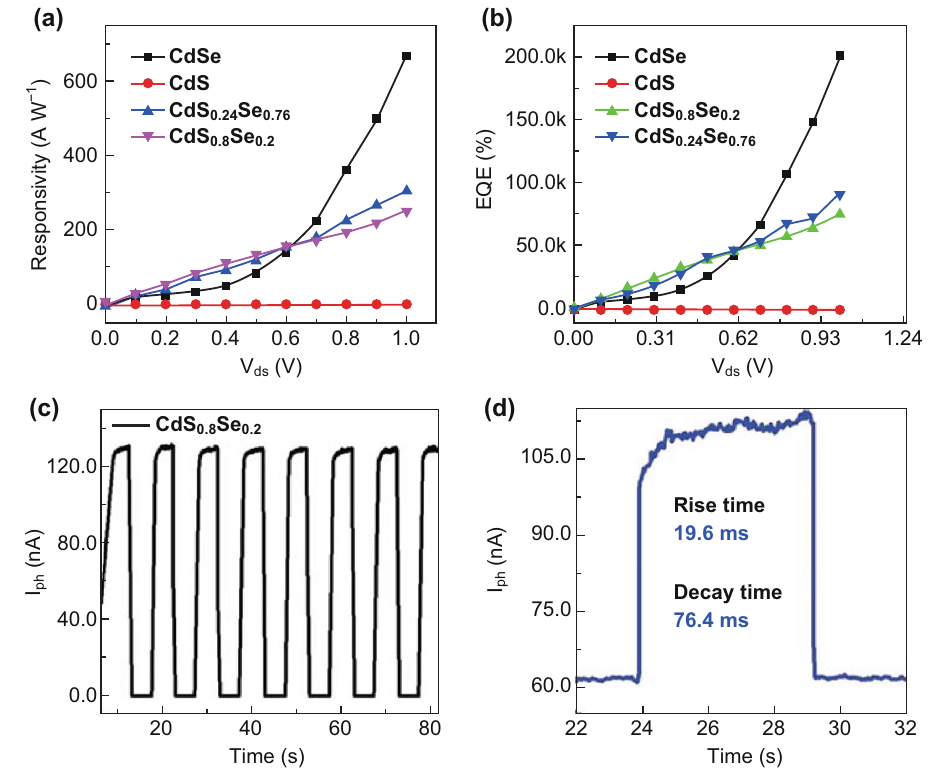
Fig. 5 Photodetection properties of the directional CdS x Se 1 - x NWs. a The responsivity of the CdS x Se 1 - x nanowire PDs. b Plot of quantum efficiency of the CdS x Se 1 - x PDs. c Time-resolved response of the device under light intensity 49.03 mW cm - 2 at a voltage of 1 V. d On/off photocurrent response and corresponding enlarged portions of the rise in response and reset process of CdS 0.8 Se 0.2 nanowires under excitation of 405 nm with a power intensity of 9.69 mW cm -